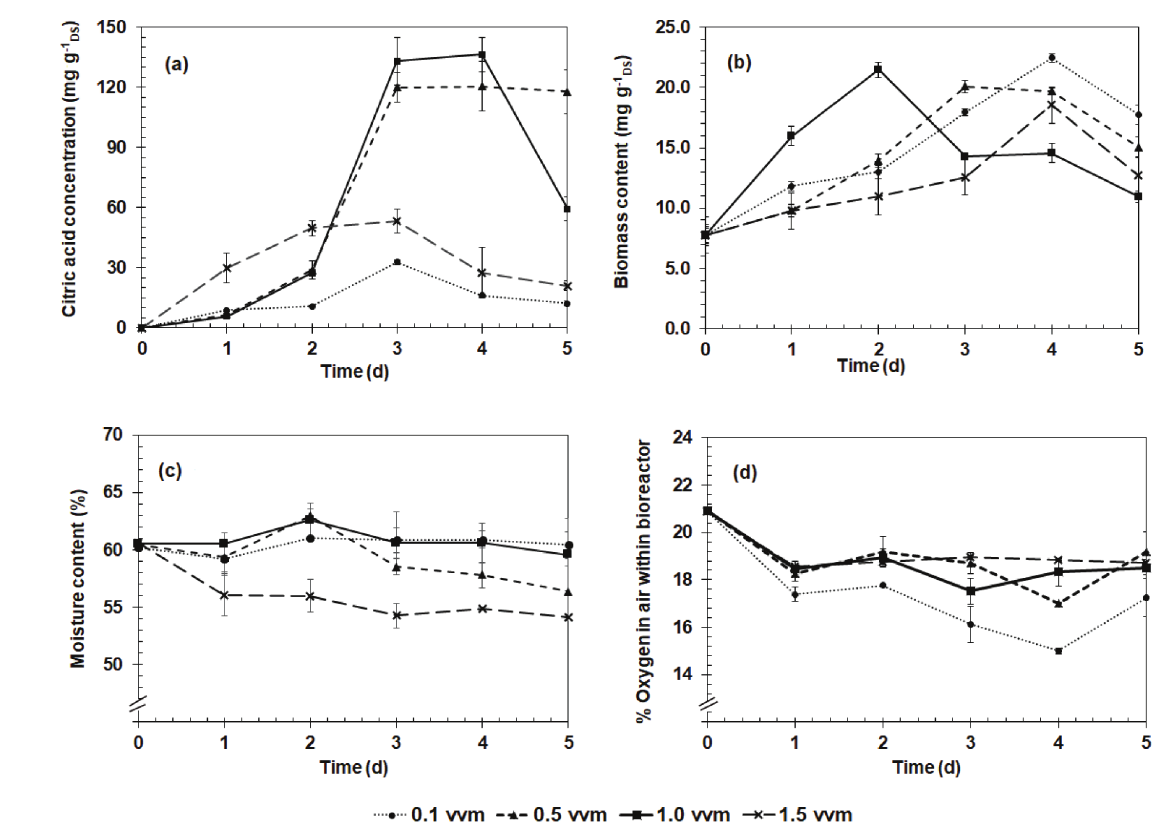
Fig. 4 – SSF of the banana peel in the 1-L glass column at different aeration rates (a) Citric acid concentration (b) Biomass content (c) Moisture content of beds (d) Oxygen